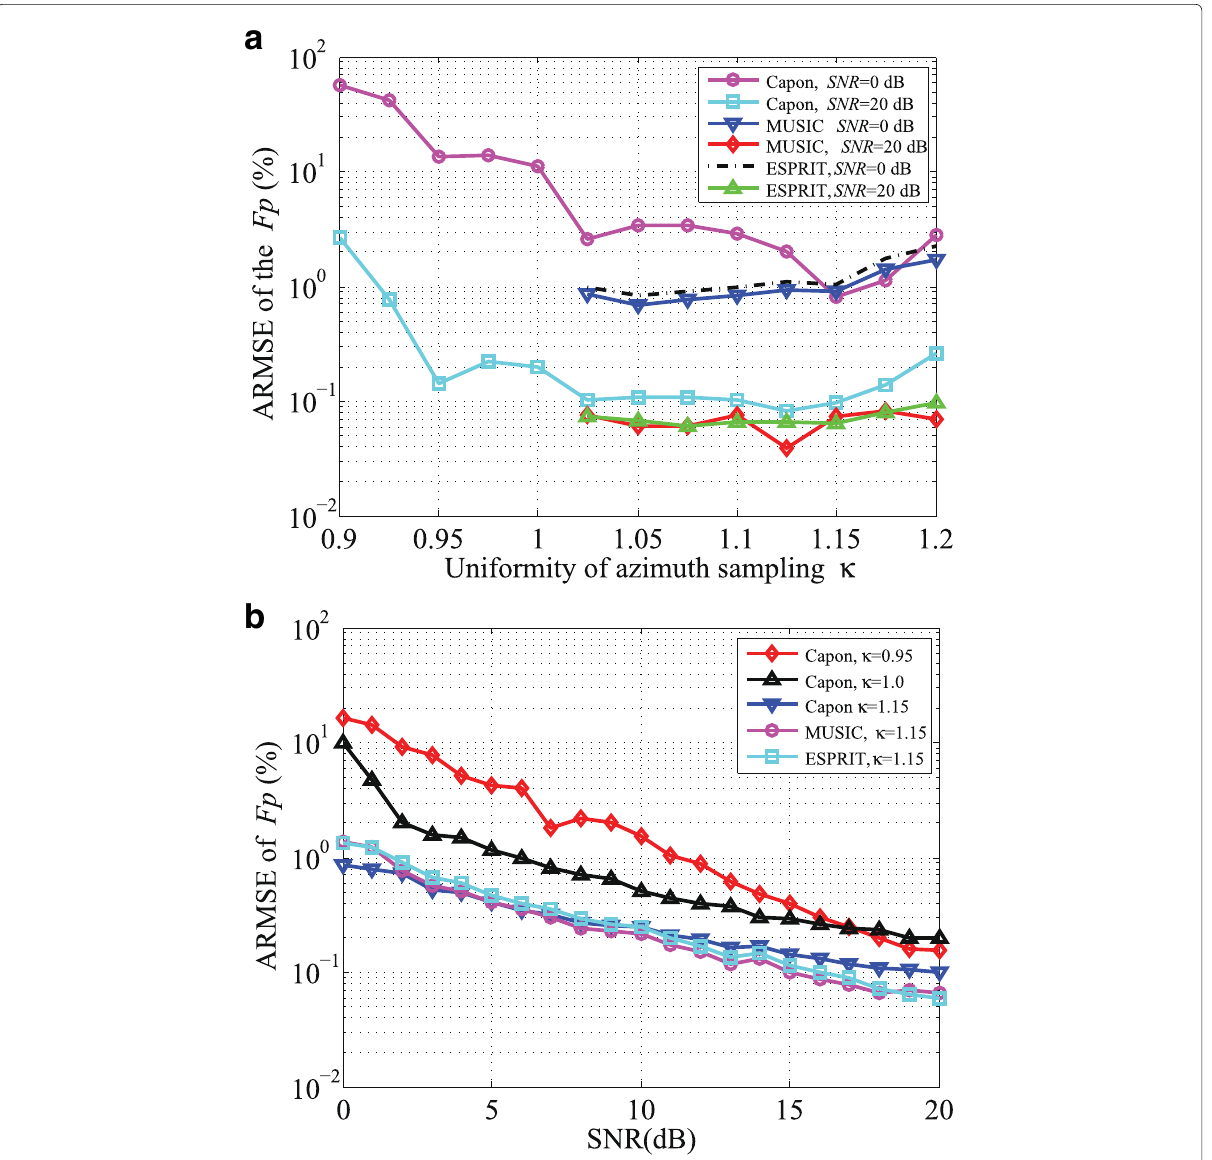
Fig. 10 ARMSE curves of F p by means of different spatial spectrum estimation techniques. a ARMSE versus SNR in different cases of κ . b ARMSE versus κ under conditions with distinct